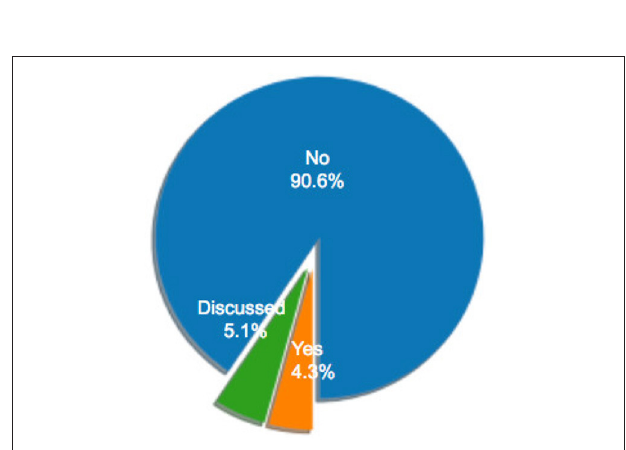
FIGURE 13 | Distribution of the application of the reliability criteria.